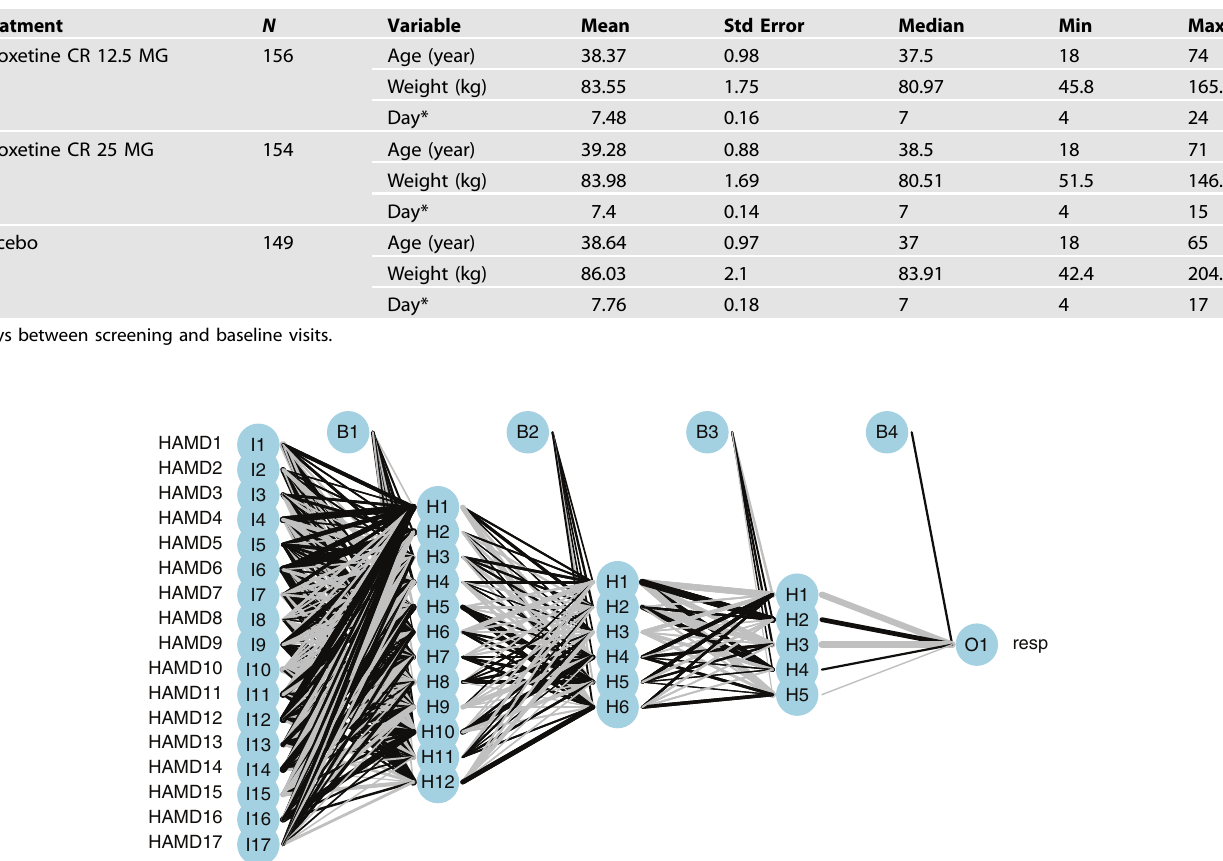
Table 1. Demographic data of the MDD population. Treatment